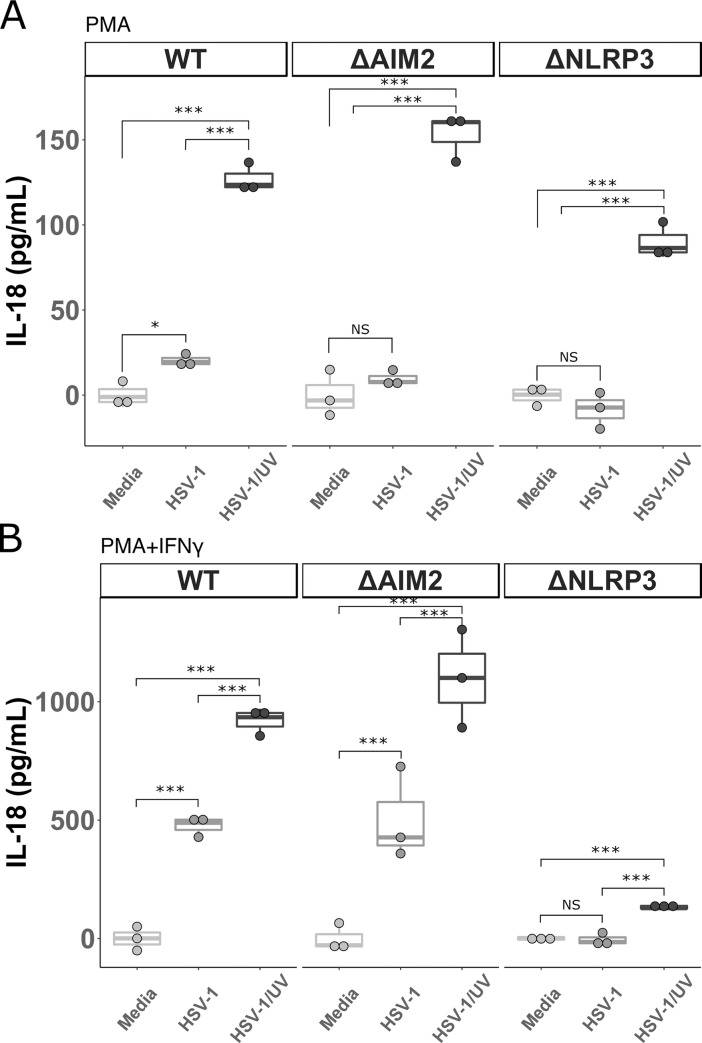
IL-18 produced by THP-1 cells after infection with UV-irradiated HSV-1.A. THP-1 cells were stimulated overnight with PMA (5 ng/mL) and then incubated with HSV-1, UV irradiated HSV-1 (HSV-1/UV), or media for 24 hours. Cell culture supernatants were collected and IL-18 was measured via ELISA. B. THP-1 cells were stimulated with PMA (5 ng/mL) and then with IFN0γ (25 ng/mL) the following day for 24 hours prior to incubation with HSV-1, UV irradiated HSV-1 (HSV-1/UV), or media alone for 24 hours. Cell culture supernatants were collected and IL-18 was measured via ELISA. ΔHUMCYC cells are labeled as “WT.” Differences between indicated conditions within a cell type were determined by a one-way ANOVA with Tukey HSD post-hoc analysis. NS, *,**,*** indicate p-values >0.05, <0.05, <0.01, <0.001 respectively.